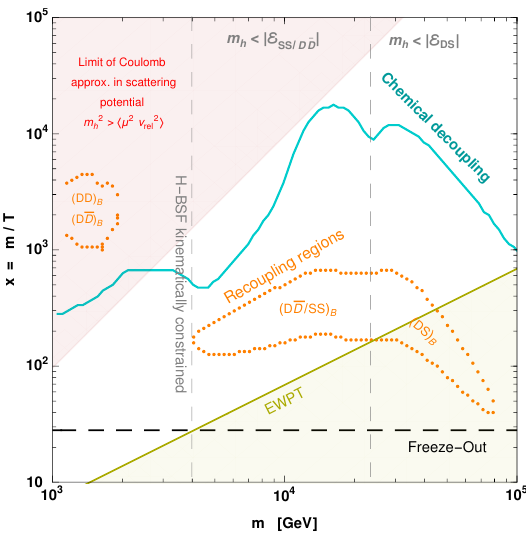
Figure 5 . Various timeposts in the DM decoupling. See text for discussion. The coupling α H is chosen as function of the mass m such that the observed DM density is reproduced by the full calculation (cf. cyan line in figure 6.) For the recoupling intervals, we indicate the bound state that has the dominant